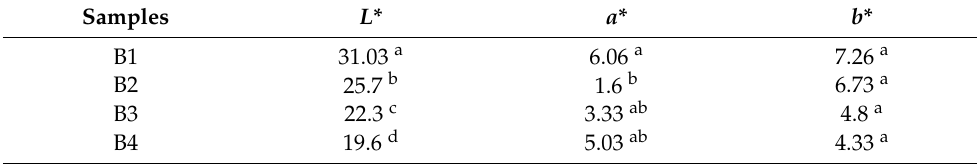
Figure 1. Color features of the fruiting body collected from different light intensity treatments. ( A–C ) Color of the fruiting bodies grown under low light intensity (B1: 10 µ mol · m − 2 · s − 1 ). ( D–F ) Color of the fruiting bodies grown under the light intensity of 50 µ mol · m − 2 · s − 1 (B2). ( G–I ) The color of the fruiting bodies grew under the light intensity of 250 µ mol · m − 2 · s − 1 (B3). ( J–L ) The color of the fruiting bodies grew under the light intensity of 500 µ mol · m − 2 · s − 1 (B4). Table 1. Color reading of the fruiting bodies collected from different light intensity